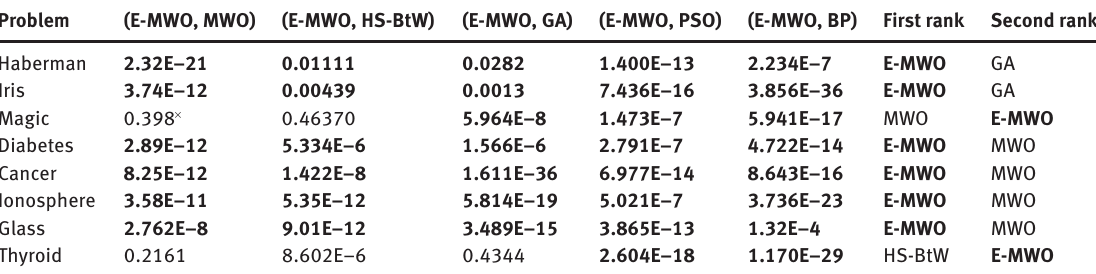
Table 5: The P Value of the t -test of Each Pair of E-MWO and the Other Training Methods for the Training Time.